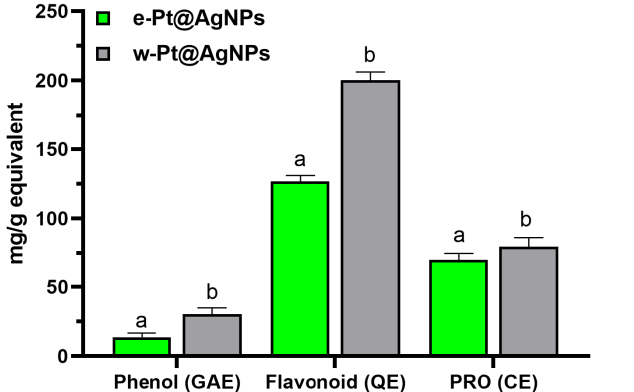
Figure 5. The polyphenolic contents were obtained after the synthesis of w -Pt@AgNPs and e -Pt@AgNPs. Values within the same histogram with different superscripts are significantly different ( p < 0.05).